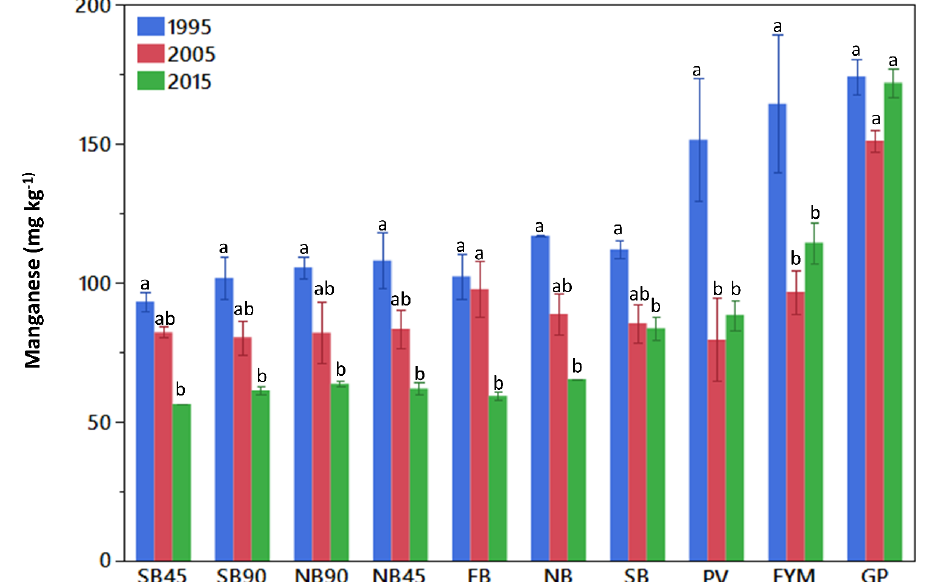
Figure 1. Mehlich III extractable manganese dynamics in upper 10-cm soil surface over 20 years in the Crop Residue Long-term Experiment (CR-LTE), Adams, OR. NB = No burn, SB = spring burn, FB = fall burn, GP = grass pasture, FYM = farmyard manure, and PV = pea vine. 0, 45, 90 accompanied by NB, SB, and FB represents rates of N applied at 0 kg ha − 1 , 45 kg ha − 1 , and 90 kg ha − 1 , respectively. Means sharing the same letter are not significantly different at 5% significance level. 3.2. Mehlich